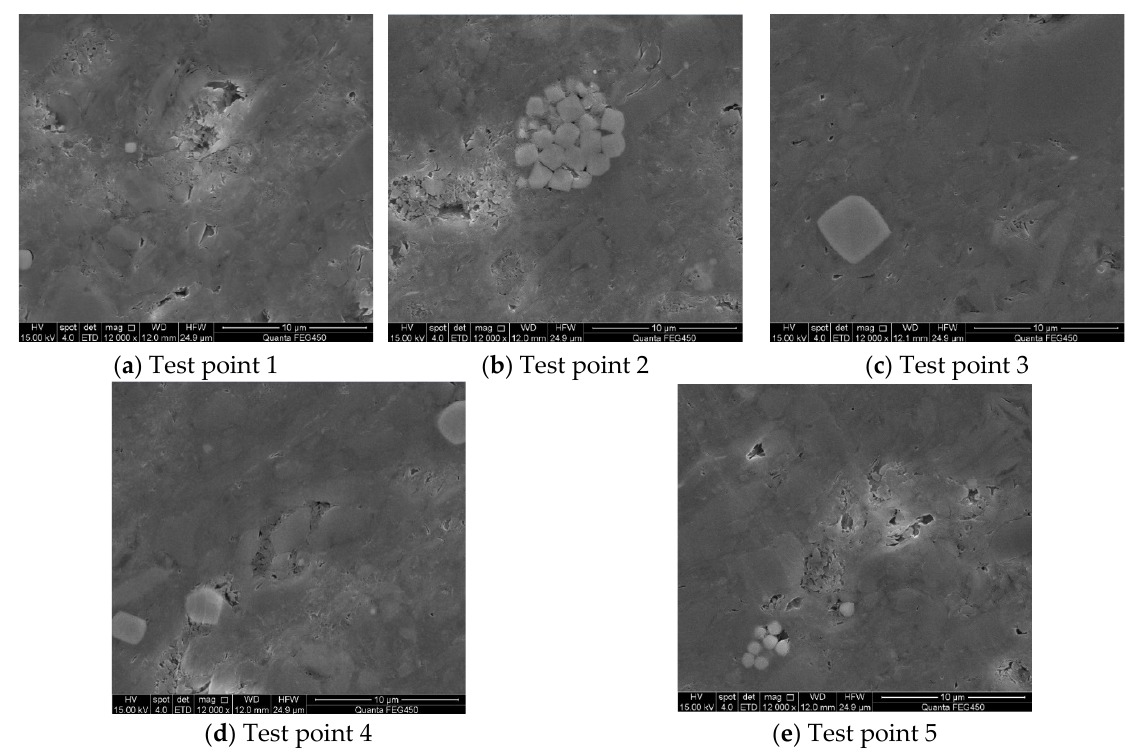
Figure 4. SEM image of CZ-Y47-1 in the direction perpendicular #1 to the bedding plane.